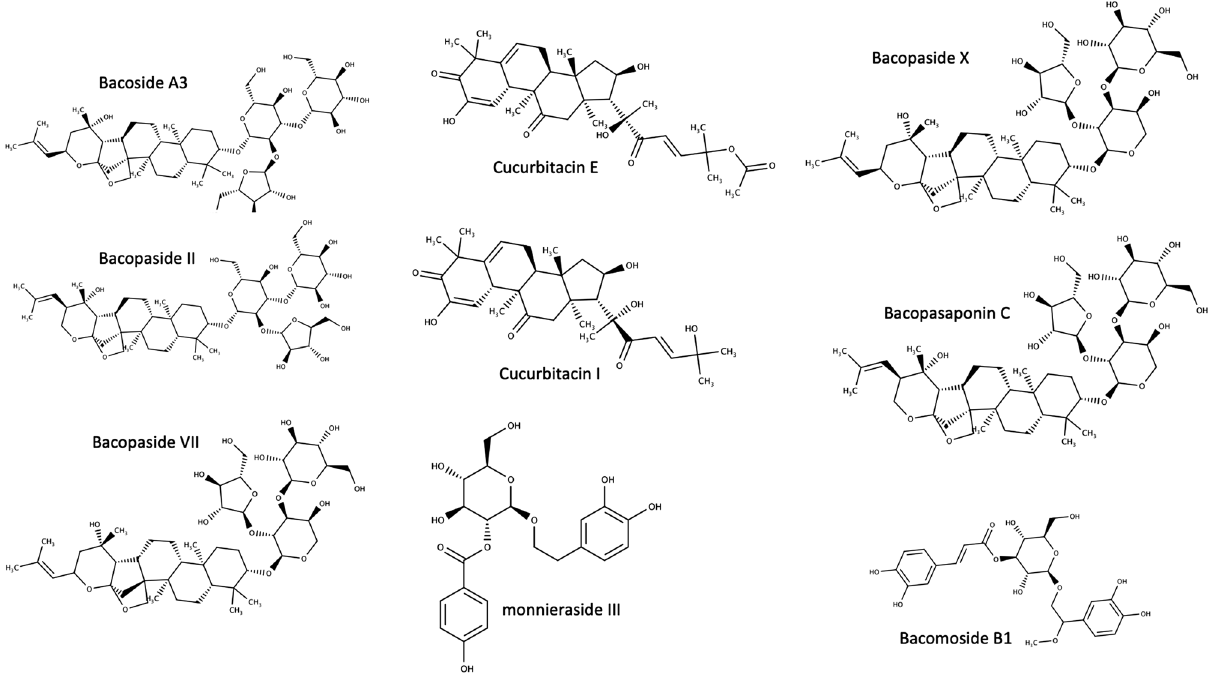
Figure 1. Structures of bacoside compounds that can be isolated from B . monnieri